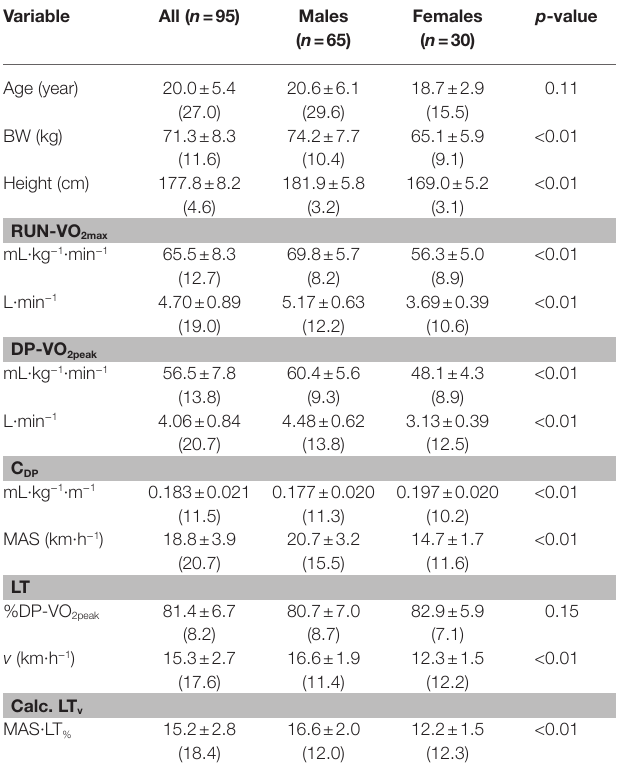
TABLE 1 | Subject characteristics at